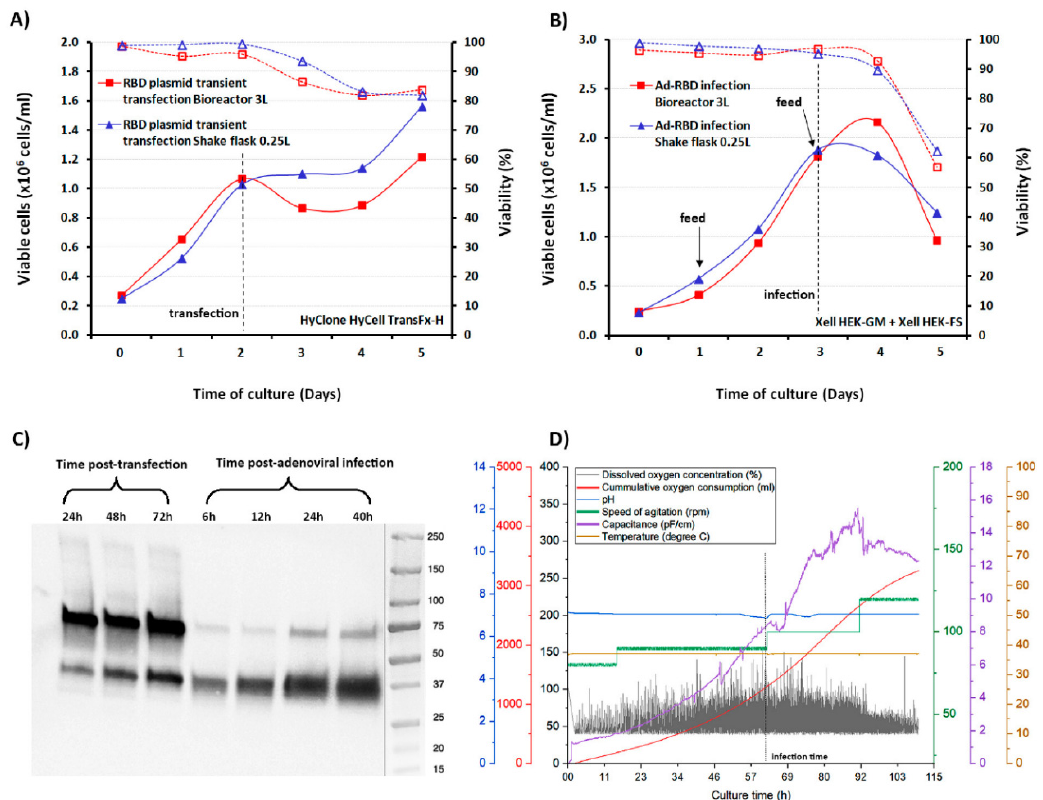
Figure 2. Characterization of RBD expression kinetics in HEK293SF cells grown at small scale in shake-flask and in 3L bioreactors, following plasmid DNA transient transfection or adenoviral infection. ( A ) Time course of the viable cell growth and cell viability of HEK293SF cells cultured in batch mode in HyCell TransFx-H medium, transfected with the plasmid pTPA_SP-RBD-His-SrtA at a cell density of 1 × 10 6 cells / mL at small scale (250 mL shake flasks) and in 3L-Bioreactor. The time of transfection for both cultures is indicated with an arrow. ( B ) Time course of the viable cell growth and viability of HEK293SF cells in Xell HEK-GM medium for RBD production mediated by Ad-hTPA_SP-RBD-His-SrtA